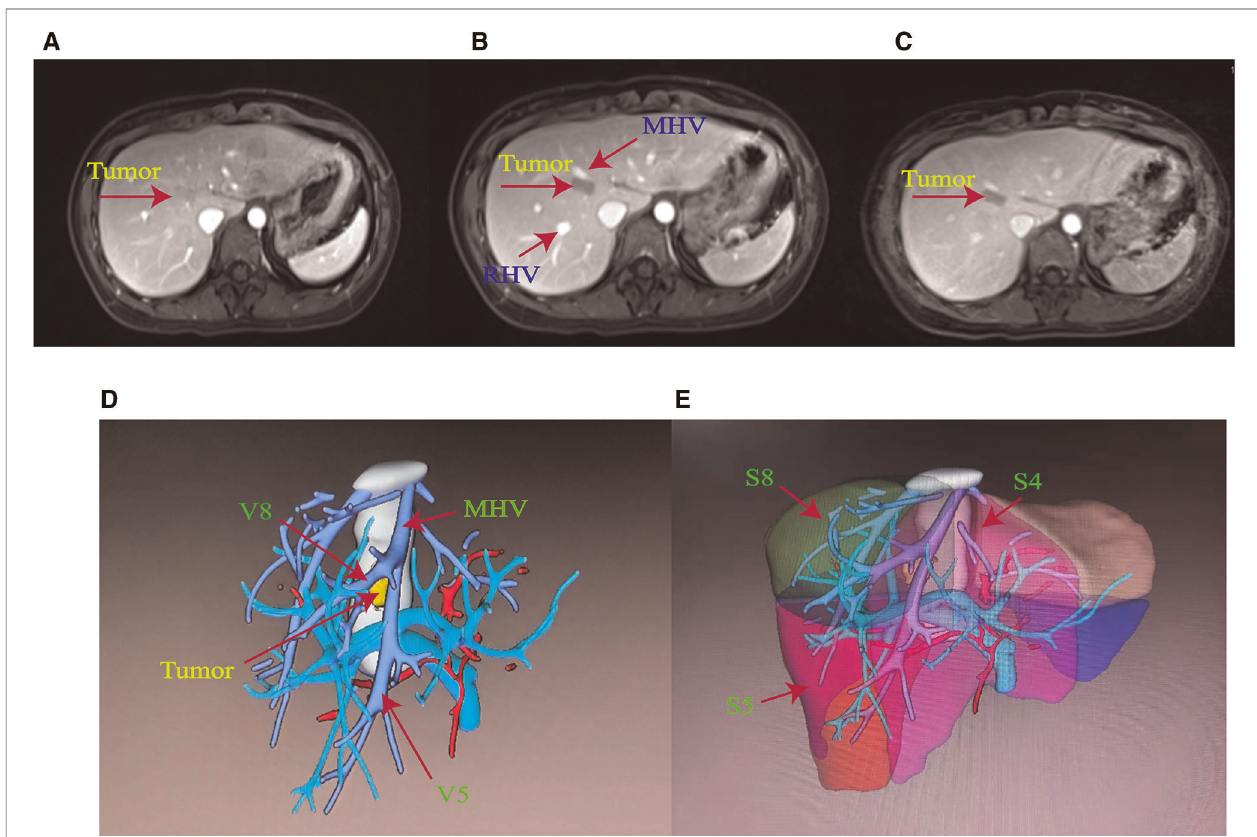
FIGURE 1 | ( A ) Preoperative MRI of the patient with enhanced arterial phase. ( B ) Preoperative MRI of the patient with enhanced venous phase. ( C ) Delayed phase of preoperative MRI enhancement in the patient. ( D ) Main hepatic vein (MHV) trunk and V5 and V8 branches were labeled in accordance with the three-dimensional stereo images of hepatic vessels reconstructed by imaging. ( E ) S4, S5, and S8 reconstruction images of liver segments.